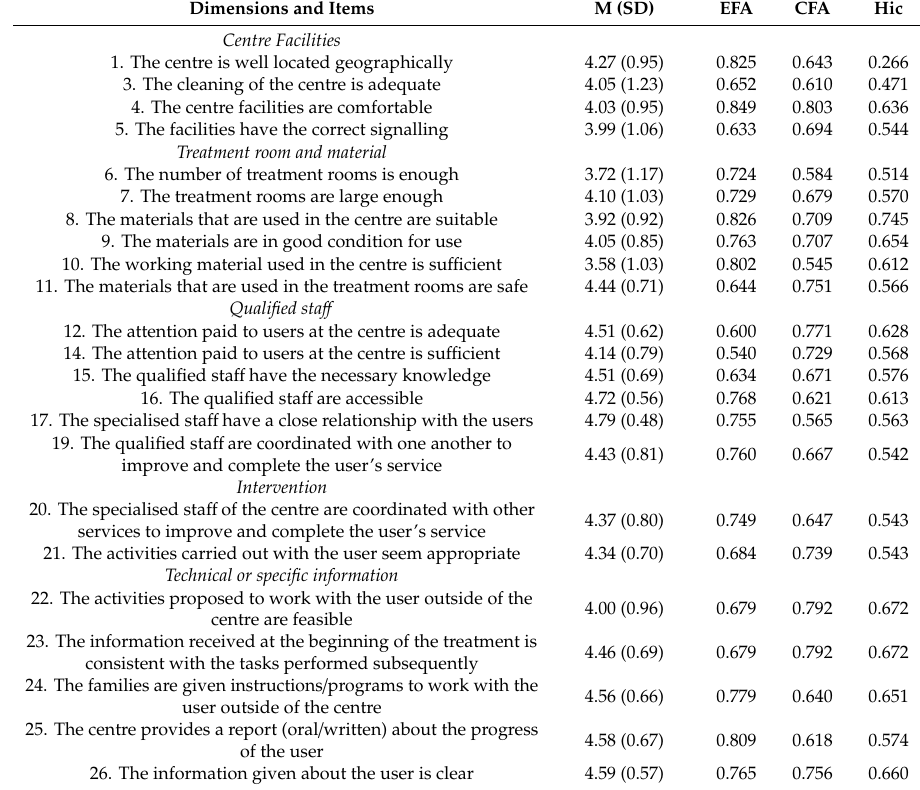
Table 3. Mean, standard deviation, factor loadings in exploratory factor analysis (EFA), confirmatory factor analysis (CFA) and homogeneity index corrected